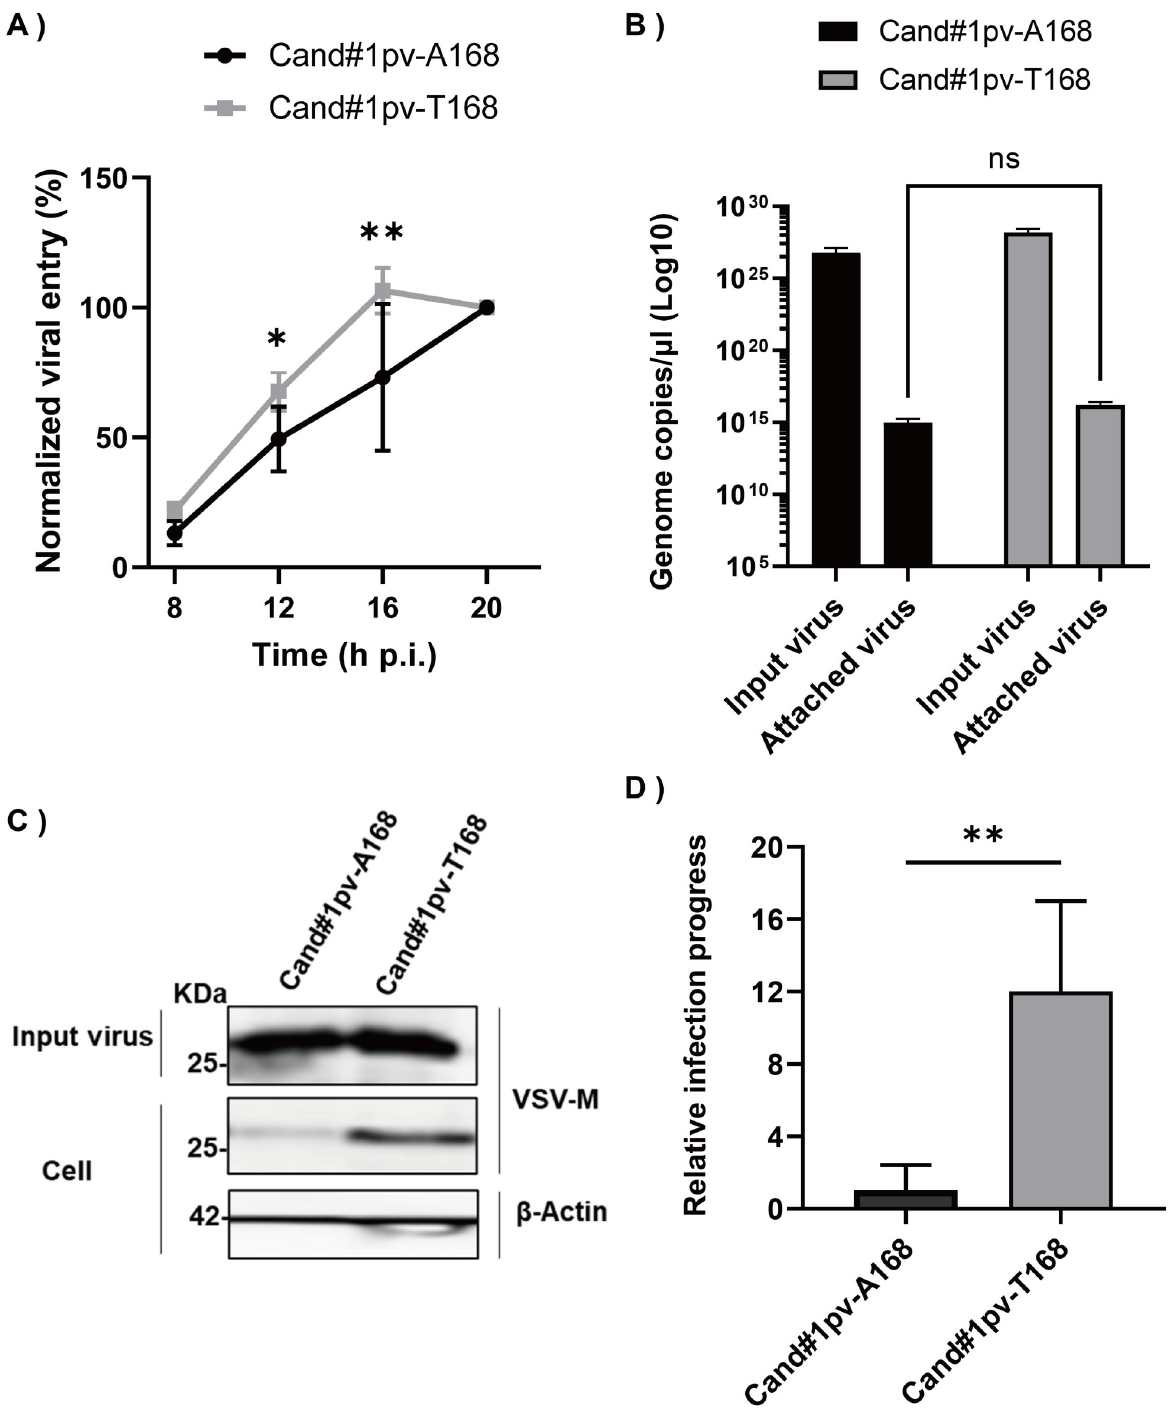
Fig 6. GPC-A168T substitution enhances viral entry dynamics. (A) 293T cells were infected with Candid#1pv-A168 or Candid#1pv-T168 virus at 4˚C to allow synchronized attachment. Unbound viral particles were removed and internalization was initiated by transferring the cells to 37˚C. Luciferase signal was measured at indicated time points. Signal at 20 hours was considered 100%. (B) Attached viral particles were quantified and normalized to the inoculum. (C) Western blot analysis (anti-VSV-M in the upper panel for the detection of the VSV-M protein, and Anti- β -Actin as loading control) to assess fusion efficiency of pseudotyped viruses. (D) Expression levels of intracellular M protein was normalized to the input virus. Quantified results of two independent experiments (n = 6) are shown. The bar indicates ± SD. Statistical significance was determined using 2-way ANOVA, ( � indicates P < 0.05 and ��� indicates P <